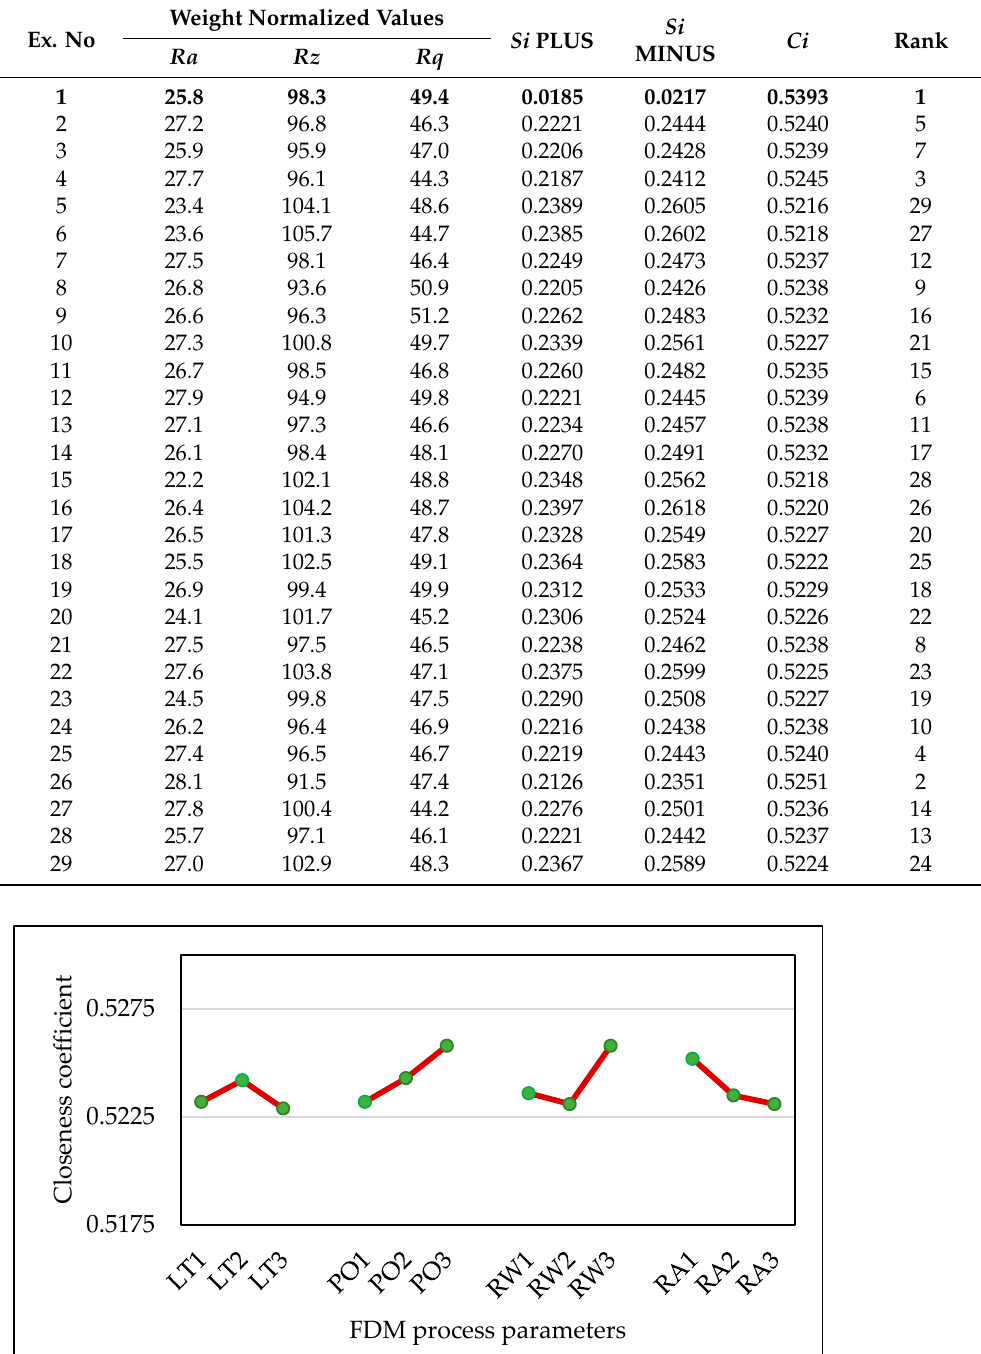
Table 6. Weight normalized matrix, separation measures and rank.